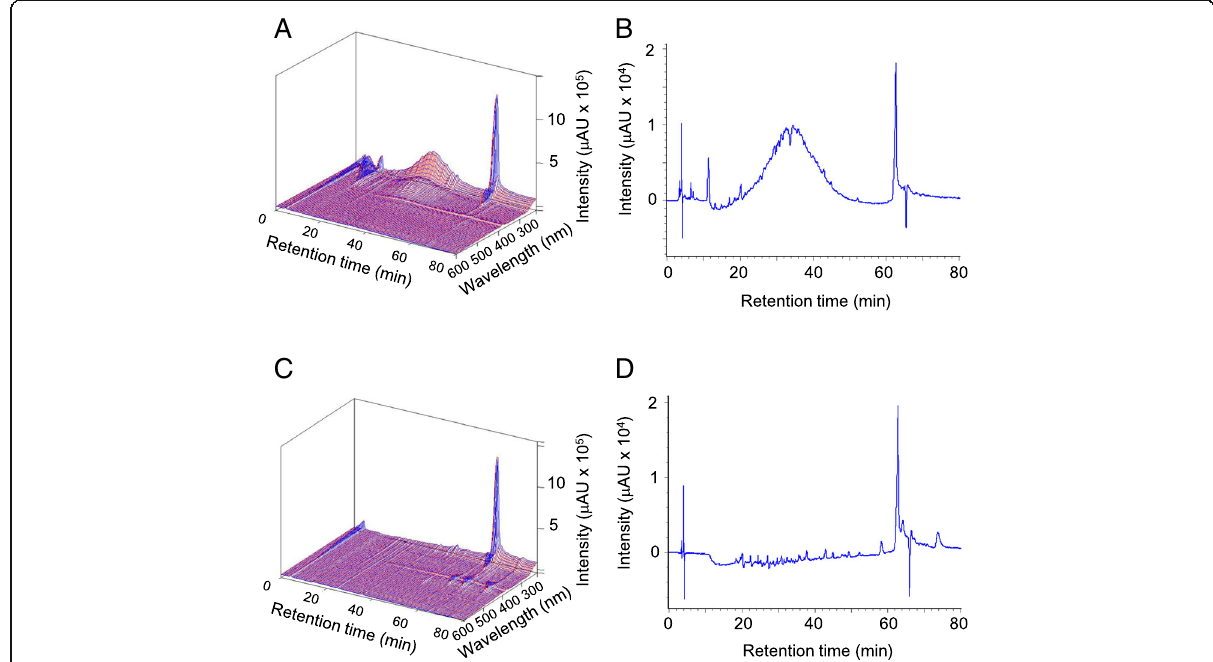
Fig. 1 3D-HPLC of S. veitchii leaf extract (SE) and sodium copper chlorophyllin (SCC). Panels a and c indicate the 3D-HPLC fingerprint of SE and SCC, respectively. Panels b and d indicate the 2D-HPLC fingerprint at 254 nm of SE and SCC, respectively. Separation was achieved using a YMC- Pack ODS-AL S-5 column. The mobile phases consisted of CH 3 CN ( a ) and 50 mM NaH 2 PO 4 aq. ( b ); linear gradient elution was performed at a flow rate of 0.8 mL/min for 60 min A:B = 10:90 ( v / v ) to 90:10 ( v / v ) and followed by isocratic condition of B:A = 90:10 ( v / v ) for 15 min, then B:A = 10:90 ( v / v ) for 5 min. The column oven temperature was held at 40 °C. Scan data were collected across the range of 220 – 600